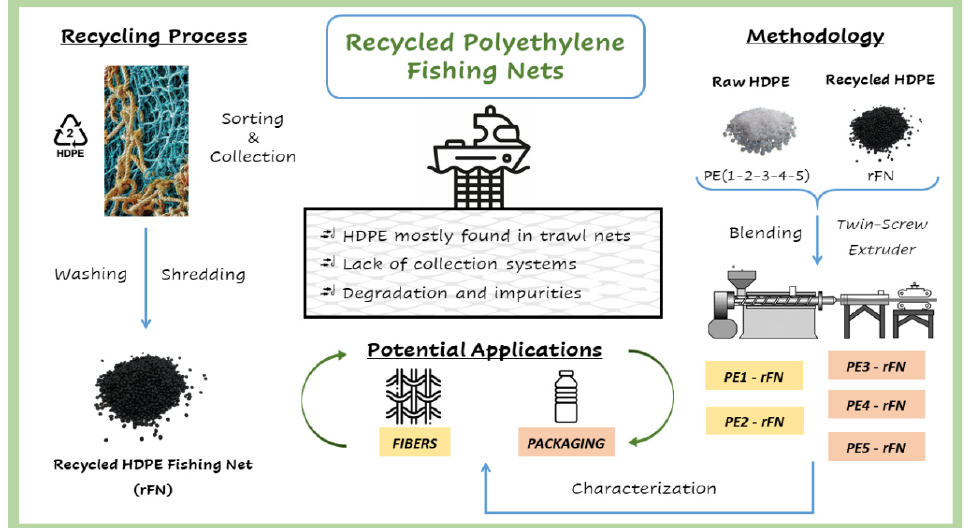
Figure 1. Flowchart of the experimental procedure.